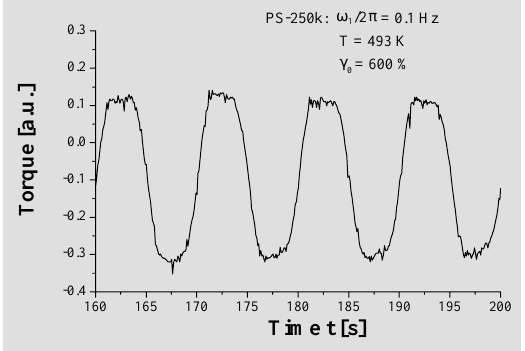
Figure 3a (left above): Typi- cal time data of PS-250k at T = 493 K, n 1 = 0.1 Hz and g 0 = 600%. Clearly the devi- ation from a pure sinusoidal response is visible. Figure 3b (right above): FT- rheology spectra corre- sponding to the time data of (a), the third, the fifth and the seventh harmonic are detectable. Figure 4 (right below): Rela- tive intensity of the third harmonic I 3/1 ( w 1 ) as a func- tion of the strain amplitude g 0 for PS-100k, PS-250k and PS-1600k at T = 493 K and n 1 = 0.1 Hz (the data set for PS-250k is a result of aver- aging over three measure- ments). Eq. 8 was used to fit the data with the restriction I n/1 ∞ = 25%. While for low molecular weight no higher harmonic could be detected within the error margin even at large strain ampli- tudes, the high molecular weight sample showed immediately a nonlinear response as detected via the third